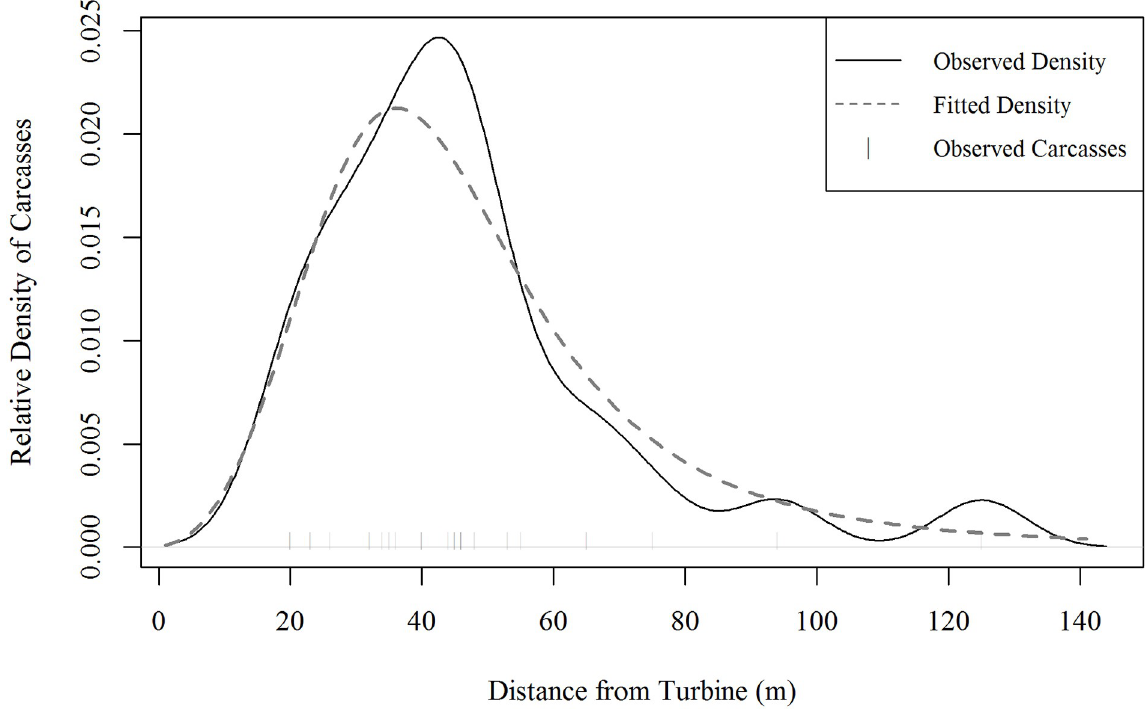
Fig 6. Fitted and observed density distribution of raptor